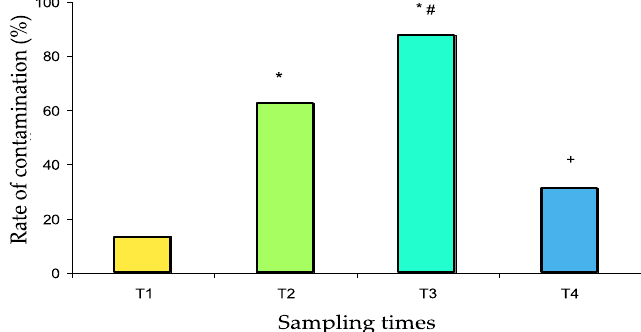
Figure 2. Contamination rate of 32 pillboxes with both susceptible and resistant bacterial strains at the different sampling times (T1 to T4). T1: after cleaning, T2: after use for medicine preparation in